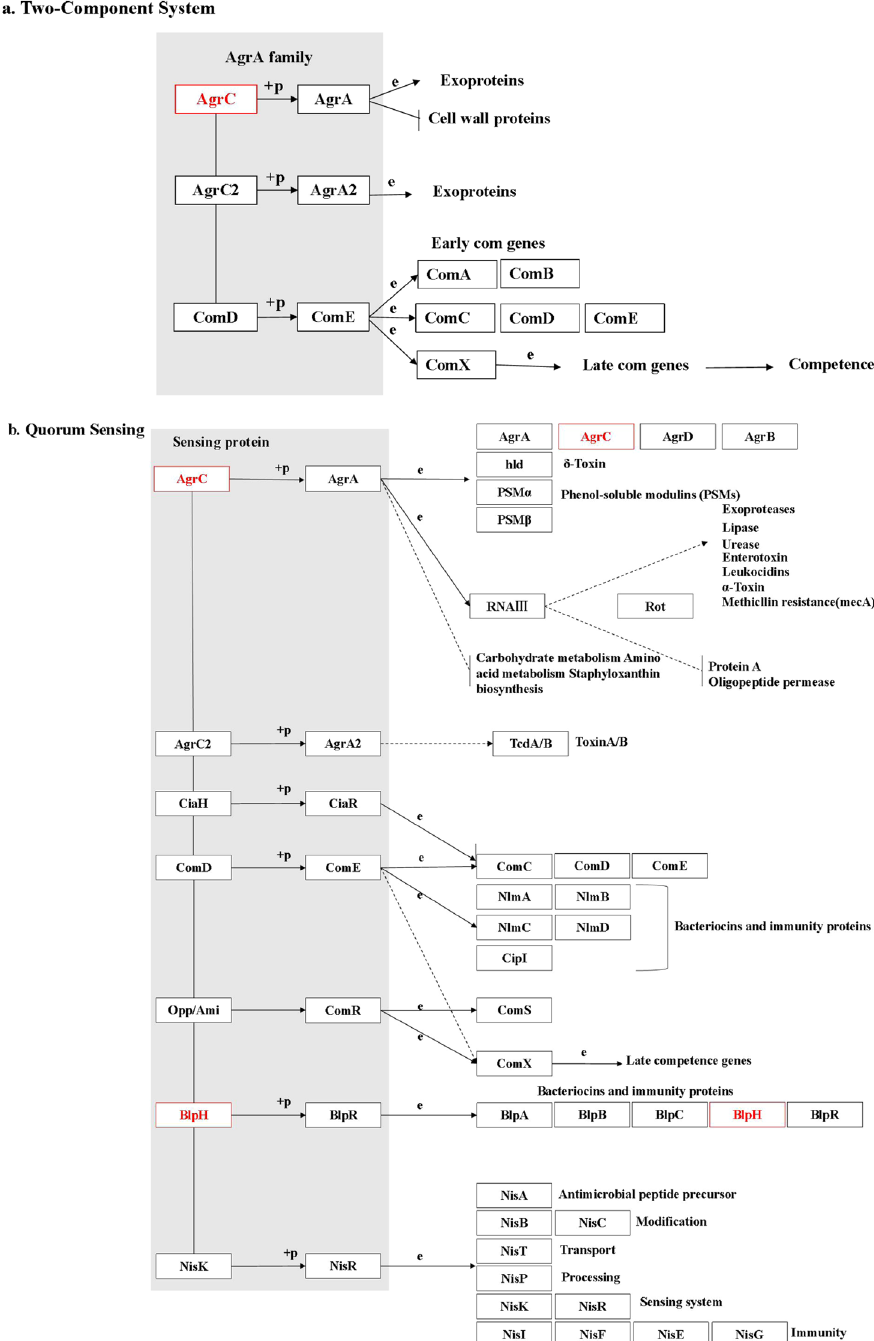
Figure 3. Kyoto Encyclopedia of Genes and Genomes (KEGG) pathway for biosynthesis of bacteriocin [( a ) two-component system, ( b ) quorum sensing]. Red represents proteins with decreased expression in L. plantarum KLDS1.0391 co-cultivated with L. helveticus KLDS1.9207 on the graphic pathway map when luxS was deleted.